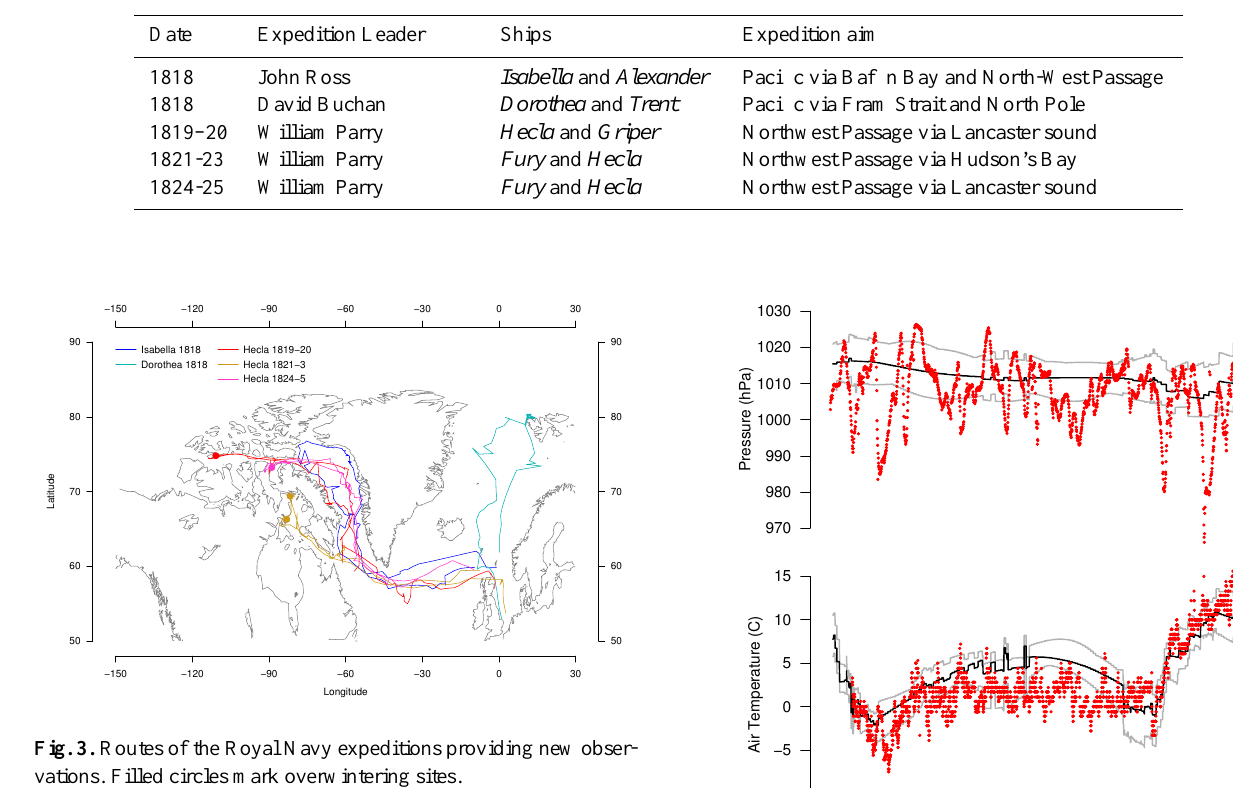
Table 1. Expeditions from which observations were digitised.